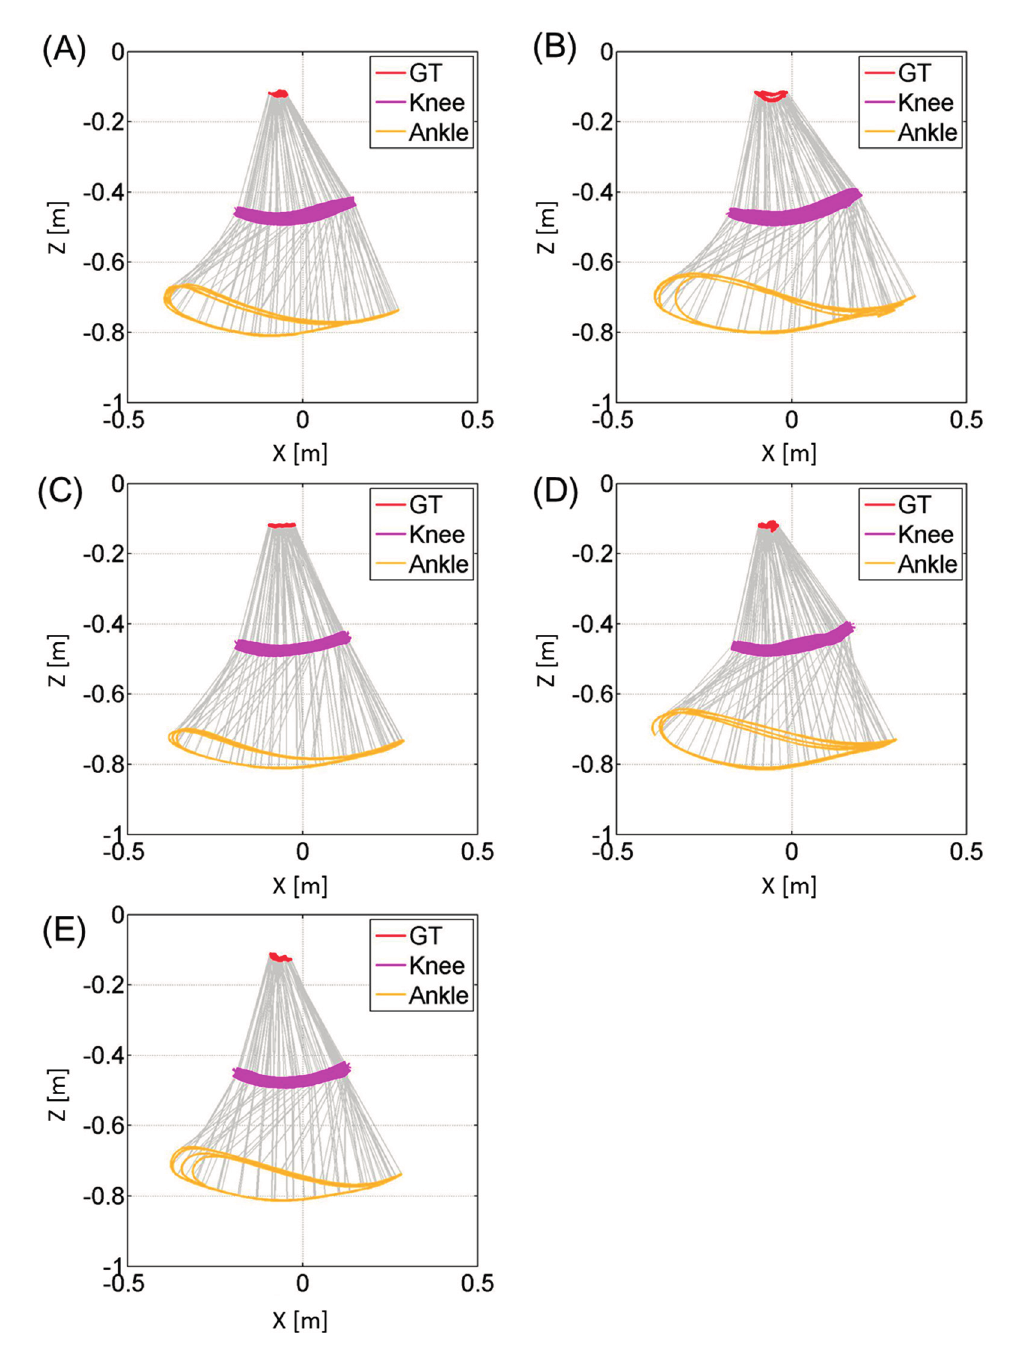
Figure 7. These figures represent the trajectories of the greater trochanter (GT), knee joint center and ankle joint center for the left leg of each subject ( A , B , C , D , E ) during three gait cycles in the sagittal plane. The vertical axis represents the Z global axis and the horizontal axis represents the X global axis. The trajectories are plotted at a sampling rate of 33